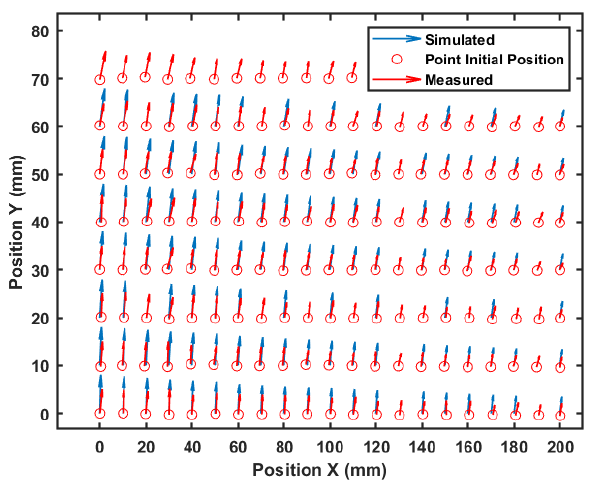
Figure 10. Movement direction for each